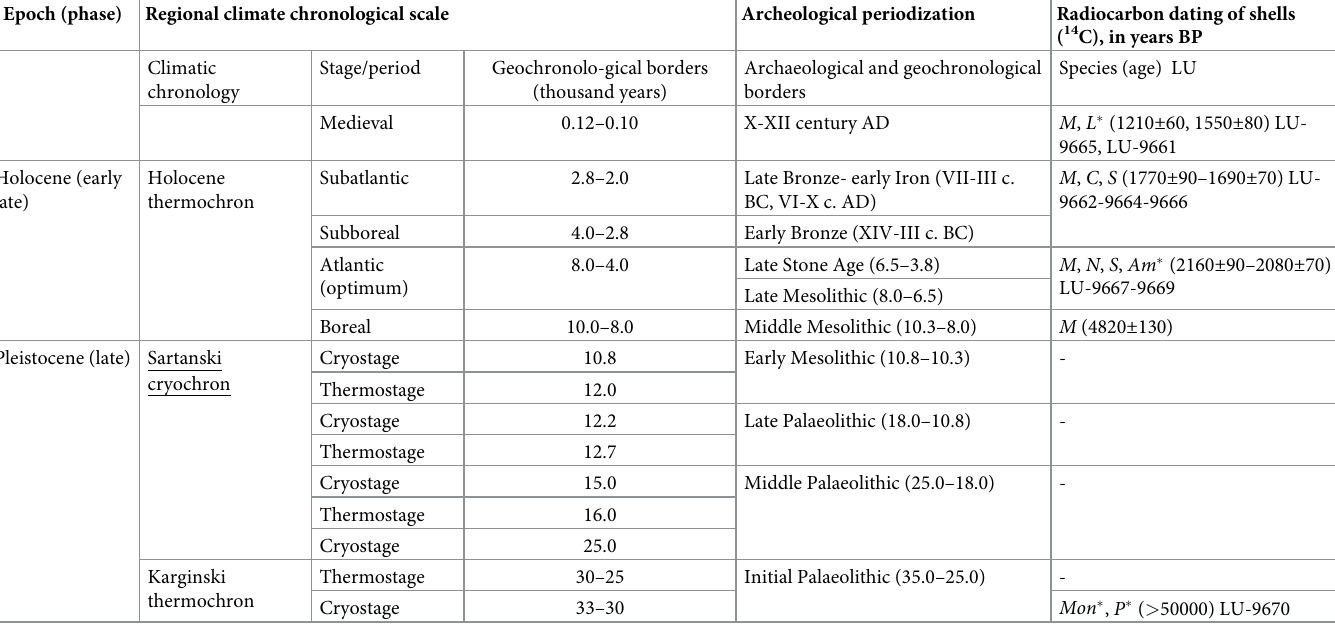
Table 2. General geochronological scale for Late Pleistocene and Holocene with regional climate chronological scale [24], subdivisions of archaeological periodiza- tion [51] and radiocarbon dating of the mollusc shells (by our data). Epoch (phase) Regional climate chronological